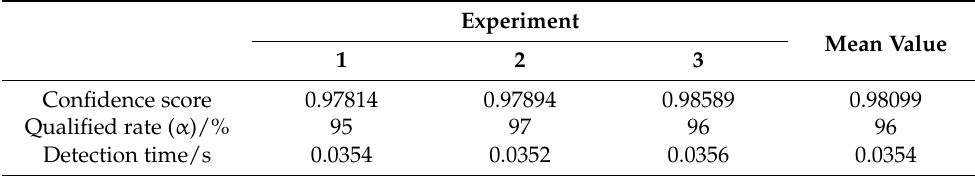
Figure 20. Comparison of before and after root cutting: (I) before, during, and after a root cutting process; (II) before, during, and after a root cutting process. Table 3. Results of the root cutting